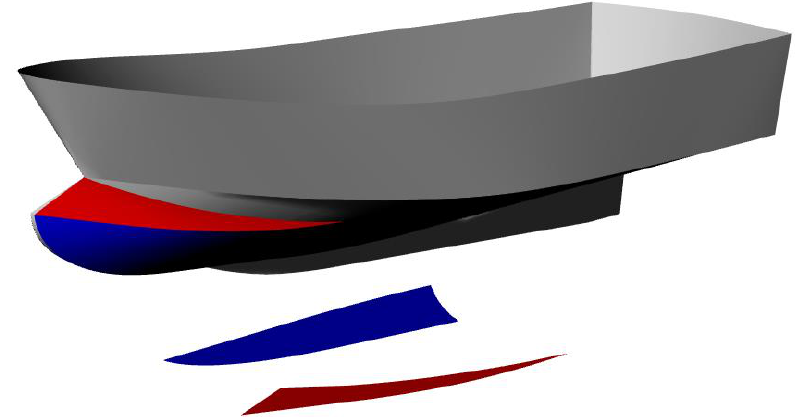
Figure 13. Rulings for the dihedral bow of example 1 (FAO4).